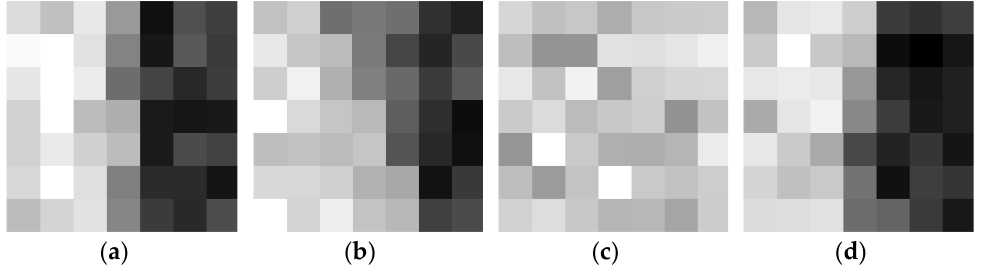
Figure 2. Enlarged image of sampling area in test image 1 ( a ) Center window ( b ) Matching window A ( 𝑡 (cid:3051),(cid:3052) = 0.1038 ) ( c ) Matching window B ( 𝑡 (cid:3051),(cid:3052) = −2.3351 ) ( d ) Matching window C ( 𝑡 (cid:3051),(cid:3052) = 0.5135 ).